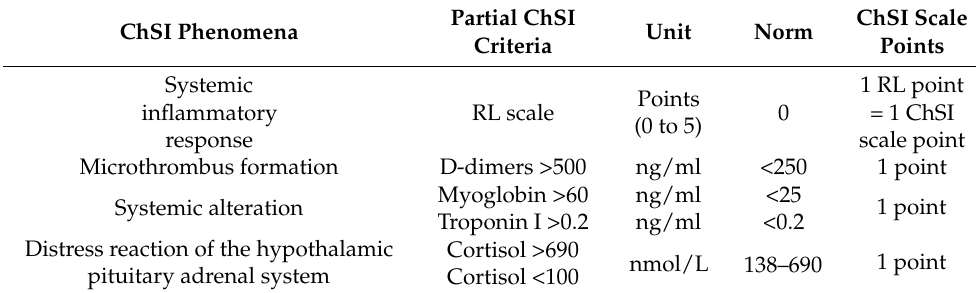
Table 1. The Chronic Systemic Inflammation (ChSI)